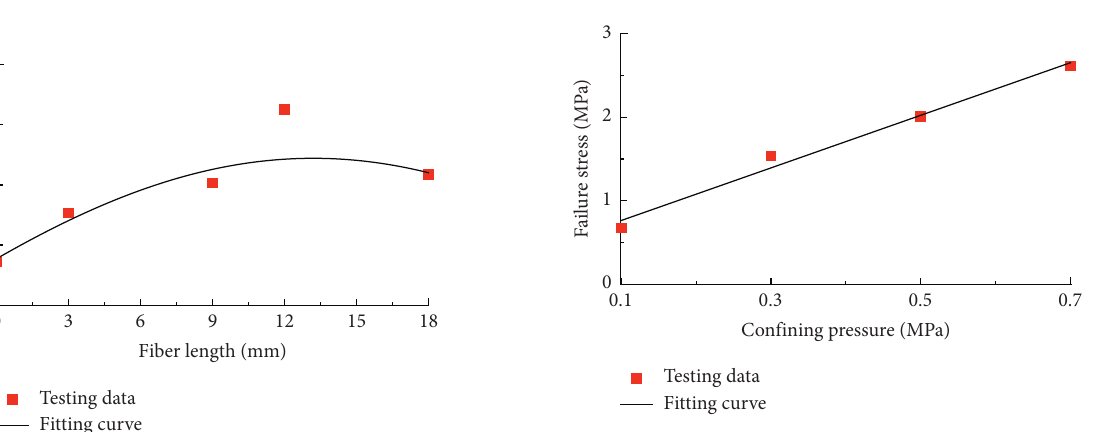
Figure 13: Deviatoric strength envelopes for fiber-reinforced soil with different confining pressure (fiber length � 12mm; compac- tion degree � 100; fiber content �